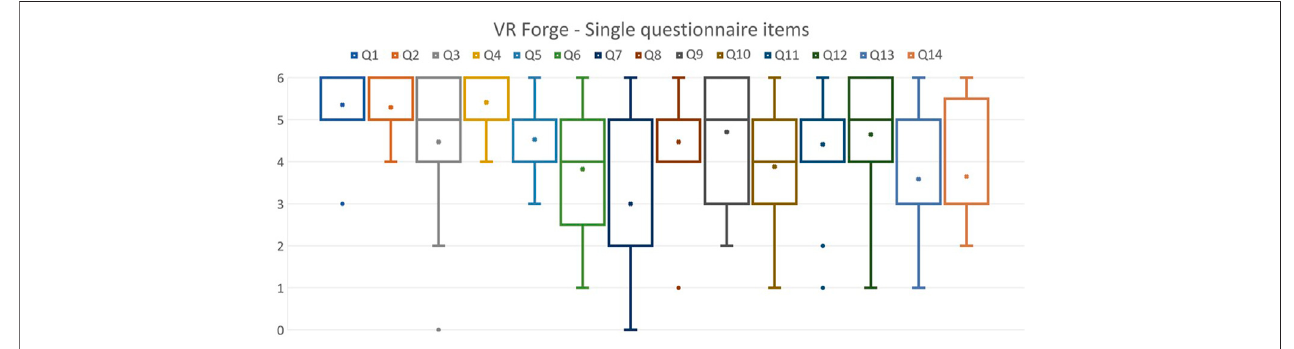
FIGURE 8 | Box and whisker plots for VR Forge ’ s items Q1 – Q14.